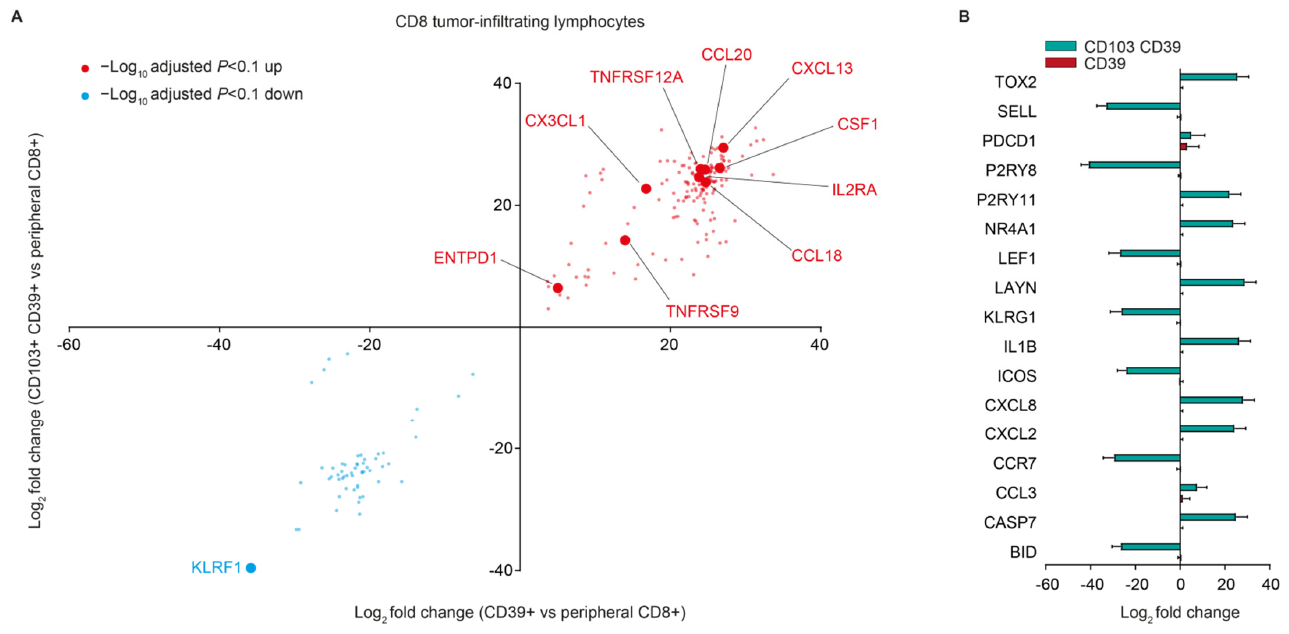
Figure 3. ( A ) Differentially expressed genes between CD103+ CD39+ and CD103 − CD39+ cells compared to peripheral blood CD8+ T cells. ( B ) Log2 fold change for the indicated genes in CD103+ CD39+ and CD103 − CD39+ cells as compared to peripheral blood CD8+ T cells.